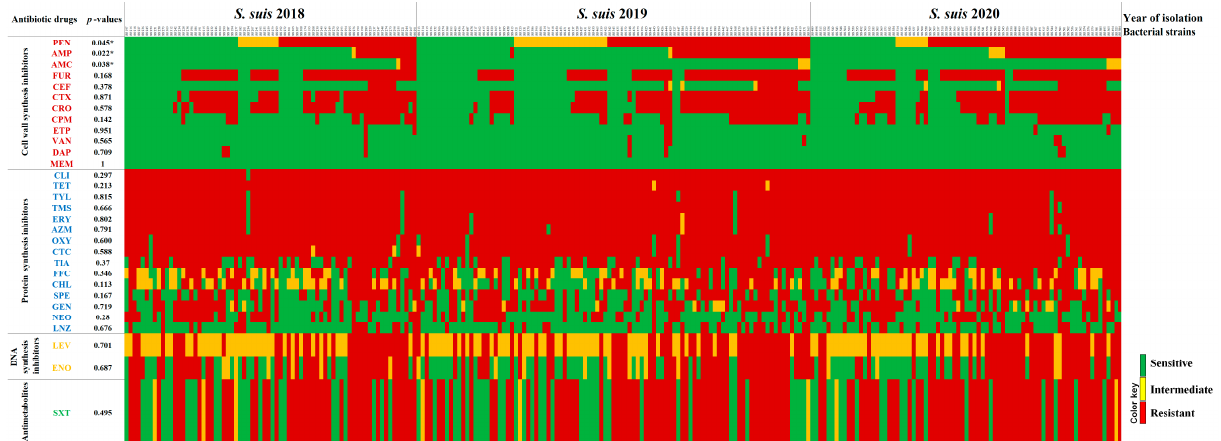
Figure 3. Heat map showing antimicrobial susceptibility profiles of S. suis strains. Rows represent antibiotics and columns represent bacterial strains, where green blocks indicate antibiotic susceptibil- ity, yellow blocks indicate intermediate, and red blocks indicate resistance action of the antibiotics. Cell wall synthesis inhibitor antibiotics: AMC, Amoxicillin/Clavulanic acid; AMP, Ampicillin; CEF, Ceftiofur; CPM, Cefepime; CRO, Ceftriaxone; CTX, Cefotaxime; DAP, Daptomycin; ETP, Ertapenem; FUR, Cefuroxime; MEM, Meropenem; PEN, Penicillin; VAN, Vancomycin. Protein synthesis inhibitor antibiotics: AZM, Azithromycin; NEO, Neomycin; CHL, Chloramphenicol; CLI, Clindamycin; CTC, Chlortetracycline; ERY, Erythromycin; FFC, Florfenicol; GEN, Gentamicin; LNZ, Linezolid; NEO, Neomycin; SPE, Spectinomycin; TET, Tetracycline; TMS, Tilmicosin; TYL, Tylosin tartrate; TIA, Tia- mulin; OXY, Oxytetracycline. Nucleic acid synthesis inhibitor antibiotics: ENO, Enrofloxacin; LEV, Levofloxacin. Antimetabolite antibiotic: SXT, Trimethoprim/sulfamethoxazole. S, susceptible; I, intermediate; R, resistant. * p -value <